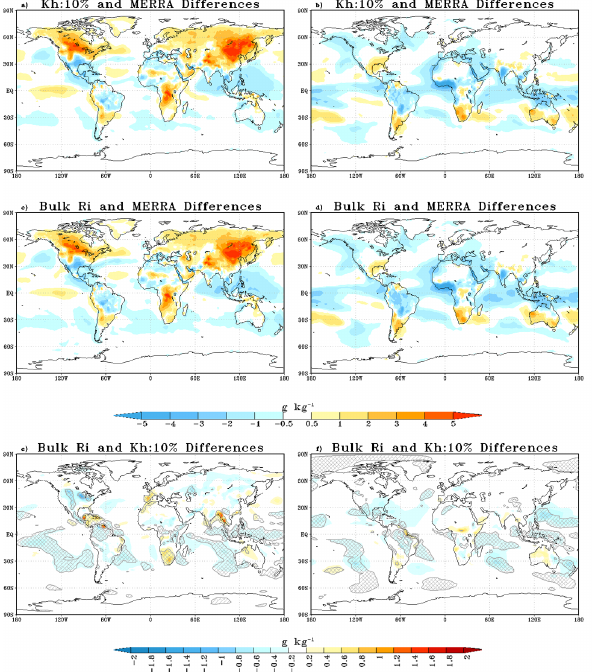
Figure 10. Seasonal mean 2m specific humidity differences. Method 2 minus MERRA for JJA (a) and DJF (b) , Method 3 minus MERRA for JJA (c) and DJF (d) , and Method 3 minus Method 2 for JJA (e) and DJF (f) . Hatch marks on the bottom plots represent significance at the 90% level using the Student’s t test. Crosshatch marks represent significance at the 95% level.